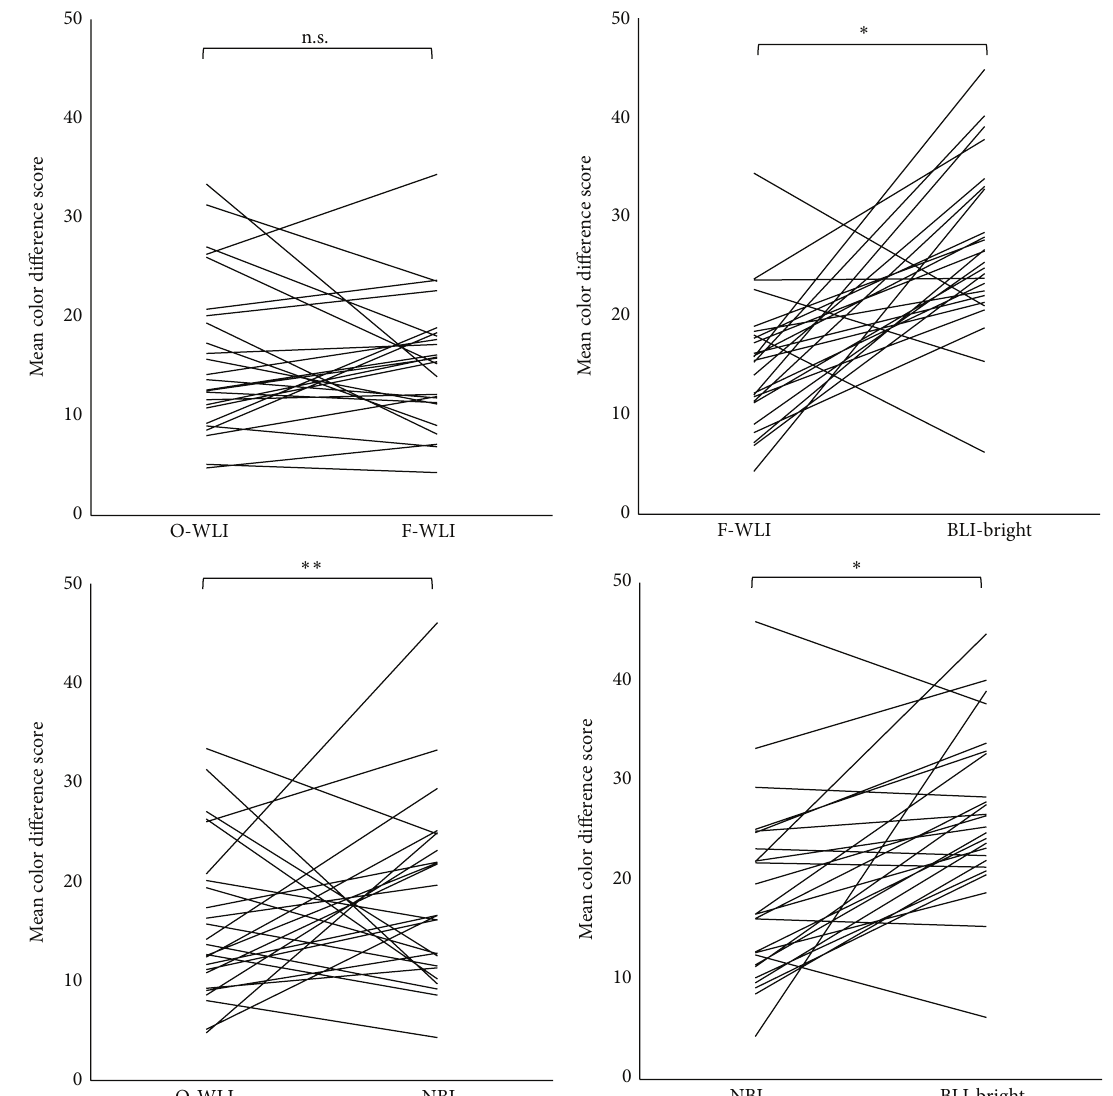
Figure 5: Objective evaluation. Statistical comparison of the mean CDS of O-WLI, F-WLI, NBI, and BLI-bright images for quality of ESCC visualization (Wilcoxon signed-rank test). n.s.: not significant. ∗ 𝑃 < 0.01 , ∗∗ 𝑃 < 0.05